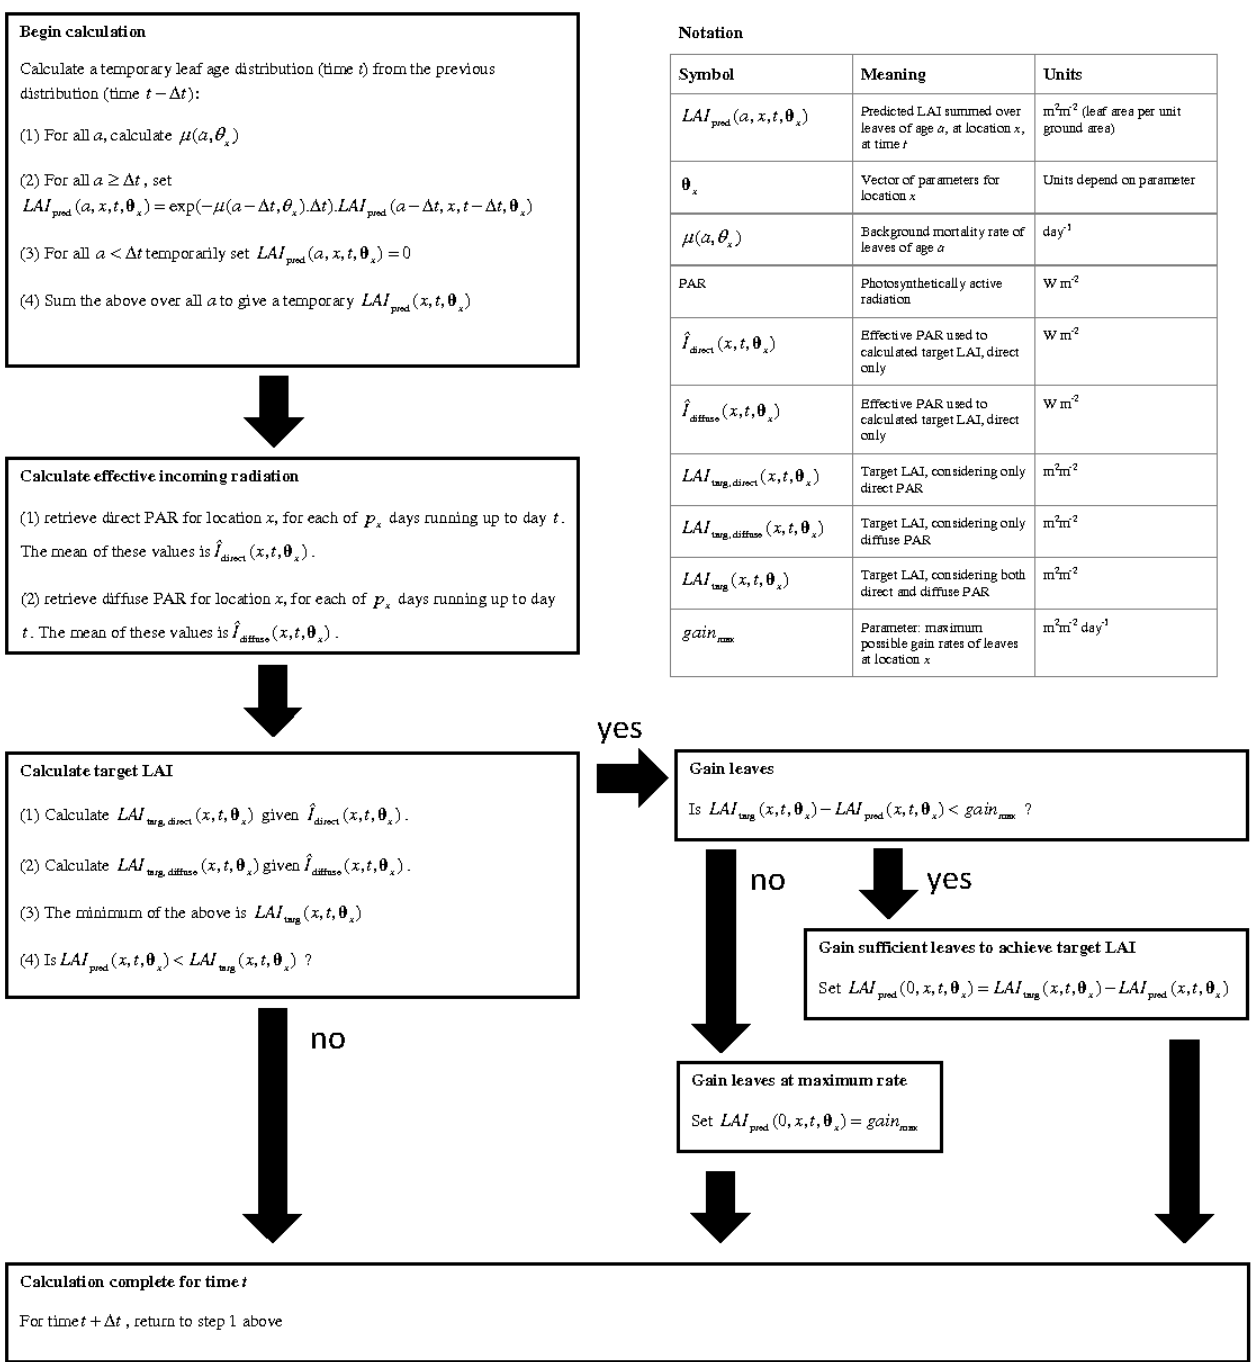
Fig. 2. How to calculate the predicted leaf age distribution and predicted total LAI for a model driven only by light. Note that the calculation begins with the leaf age distribution from a previous time t − δt at the same location, which is updated to account for background leaf mortality, and the addition of new (age = 0) leaves as driven by the LAI target, producing a predicted leaf age distribution for time t